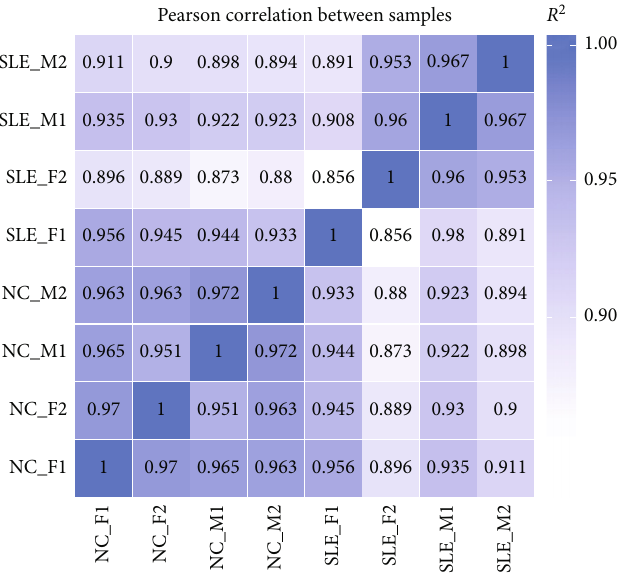
Figure 1: Correlation heat map analysis. SLE and controls presented distinct clusters based on the miRNA expression pro fi les of the eight specimens except for SLE_F1.